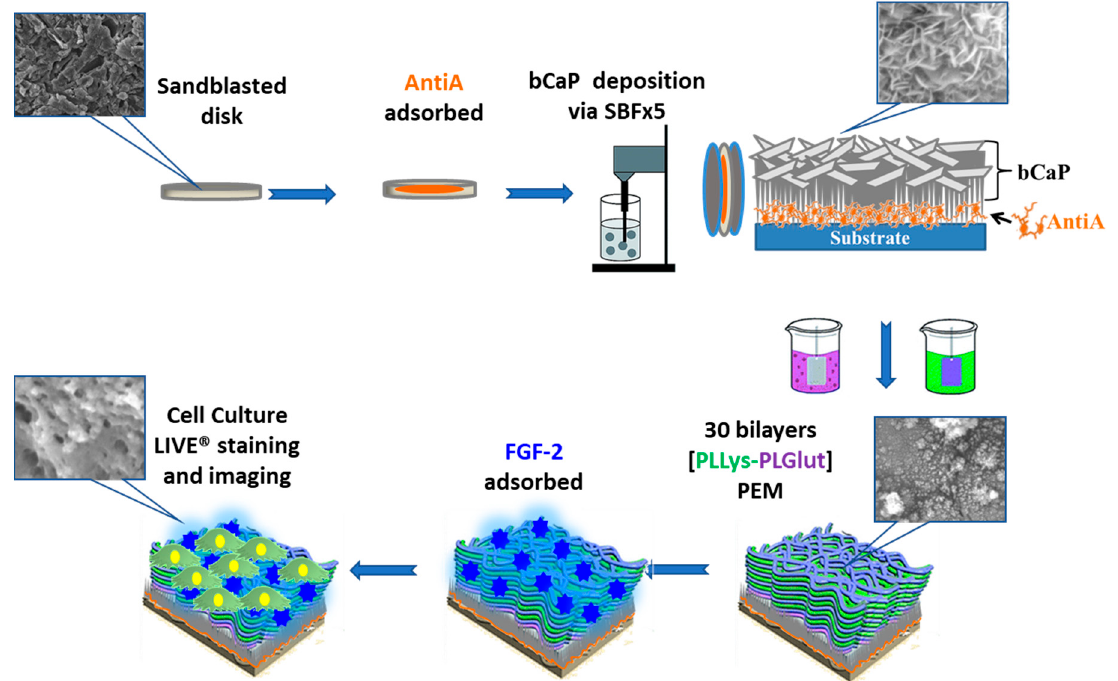
Figure 1. Schematic representation of the bone-like apatite coating (bCaP)/Poly- D -Glutamic Acid (PEM-D) application process and analysis techniques.